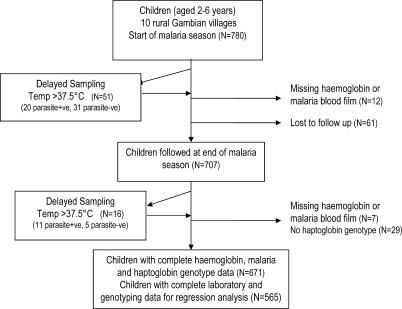
Sample ConstructionAt the start of the malaria season, 780 children (aged 2–6 y) were recruited from ten rural Gambian villages, of these, 61 children were lost to follow-up (of whom four died). At the end of the malaria season, 707 children were surveyed. A total of 671 children had complete haemoglobin, malaria blood film, and haptoglobin genotype data. After biochemical assays and further genotyping, 565 children had complete data for multivariate regression analysis.